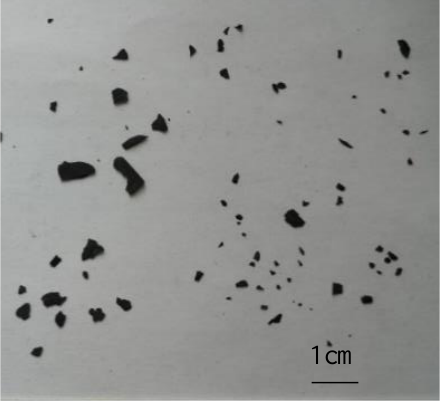
Figure 14. Dropped particles of the WY-1 shale sample.